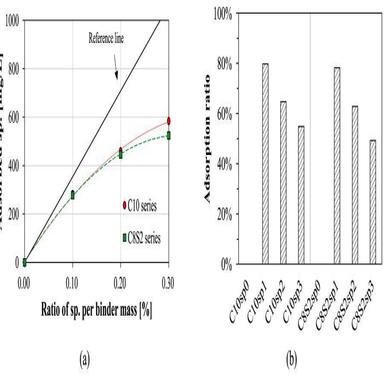
Adsorption of superplasticizer in C10 and C8S2 samples: (a) adsorbed amount and (b) adsorption ratio of superplasticizer.